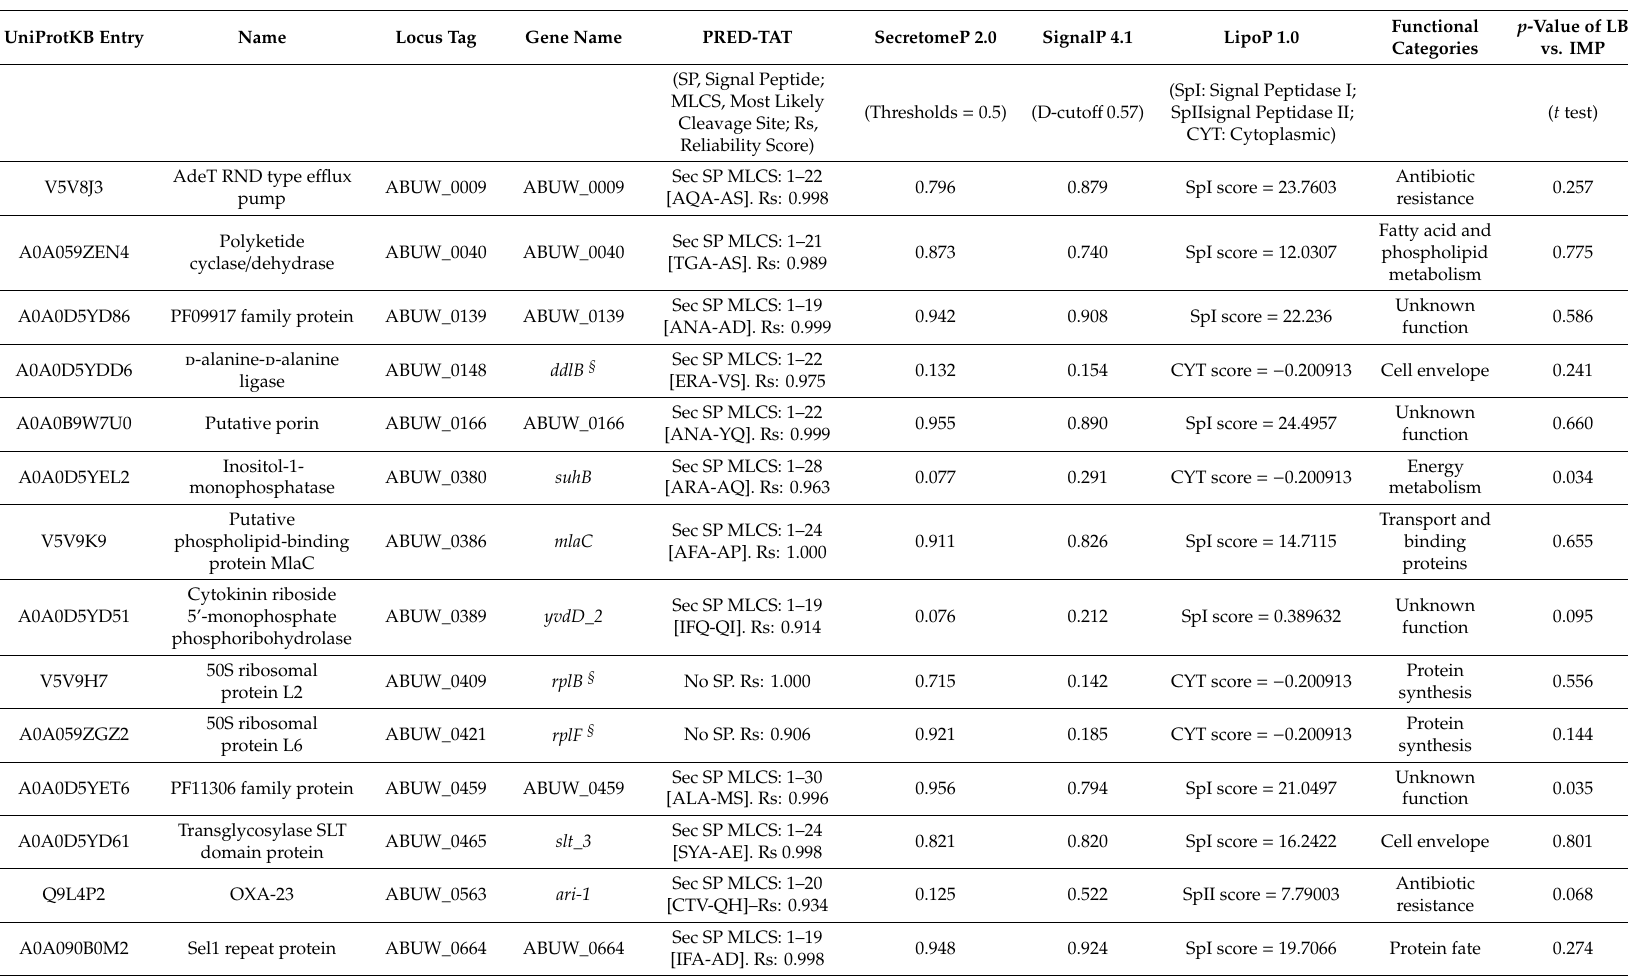
Table 1. Di ff erentially expressed periplasmic proteins identified in A. baumannii AB5075 grown in LB or LB supplemented with IMP using a semi-quantitative